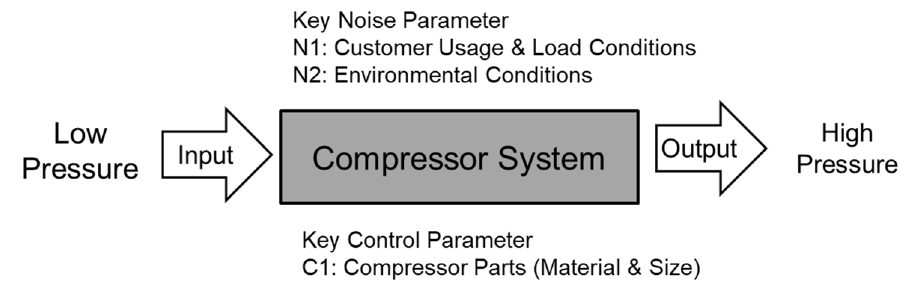
Figure 3. Parameter diagram of compressor (example).